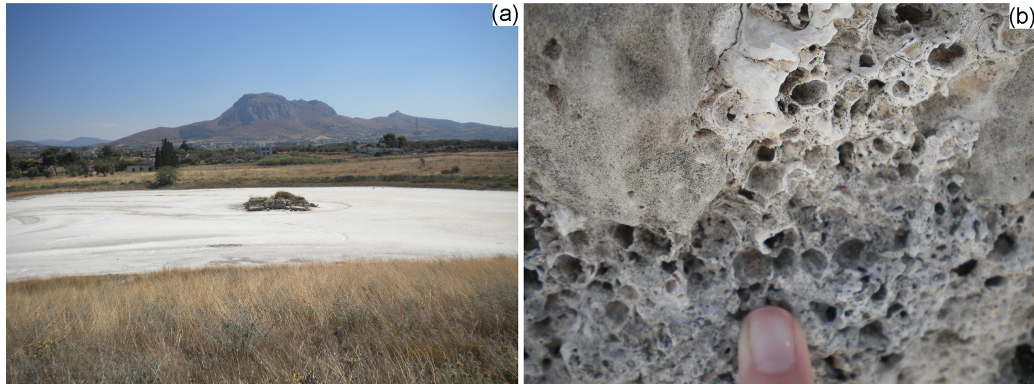
Figure 3. (a) Part of the main silted harbour in Lechaeum, in the middle of which a rectangular structure is visible. Coring samples in this area revealed that tectonic uplift in combination with the location of the harbour in a serpentine depression were the primary factors for its abandonment (Morhange et al., 2012). (b) Closer view of the structure where uplifted Balanus perforatus fossils in growth position suggest a biological sea level at + 1.2m, with the age of the uplift at 375 ± 120calBCE (Morhange et al.,